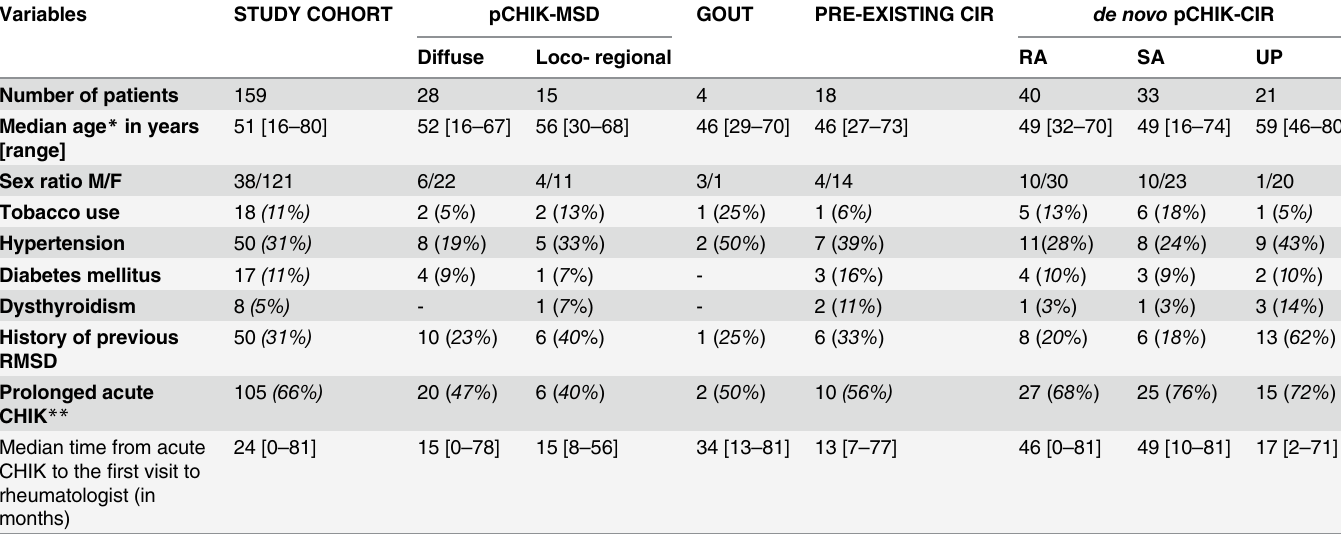
Median time from acute CHIK to the fi rst visit